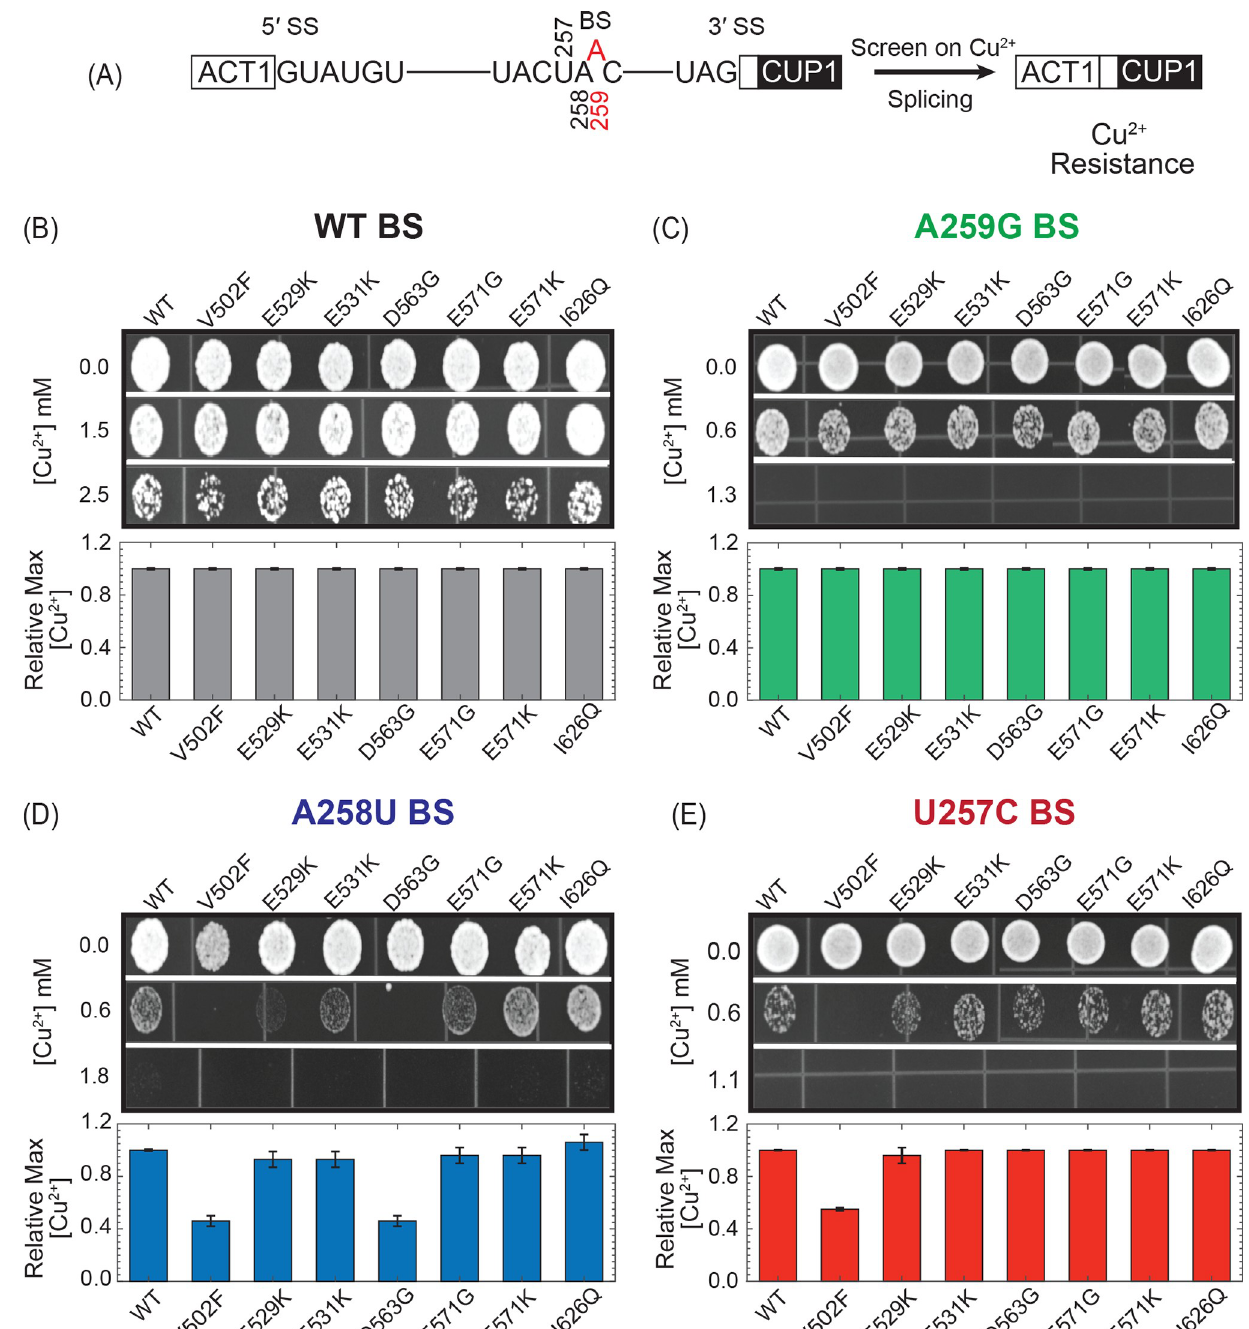
Fig 2. Impact of LBU-mutants on yeast growth using the ACT1-CUP1 reporter. (A) Schematic of the ACT1-CUP1 reporter assay and sequences of the yeast 5’ SS, BS, and 3’ SS. The branchpoint adenosine A259 is colored red. (B) Results of ACT1-CUP1 Cu 2+ growth assays of Hsh155 WT and mutant strains carrying ACT1-CUP1 reporter plasmids with consensus SS. (C-E) Results of ACT1-CUP1 Cu 2+ growth assay of Hsh155 WT and mutant strains carrying ACT1-CUP1 reporter plasmids with nonconsensus BS. For panels B-E, representative images of yeast grown on Cu 2+ -containing plates are shown at the top, and the bar graph in the bottom panel represents the average and standard deviation from three replicates of the maximum [Cu 2+ ] at which yeast strain survived relative to Hsh155 WT .